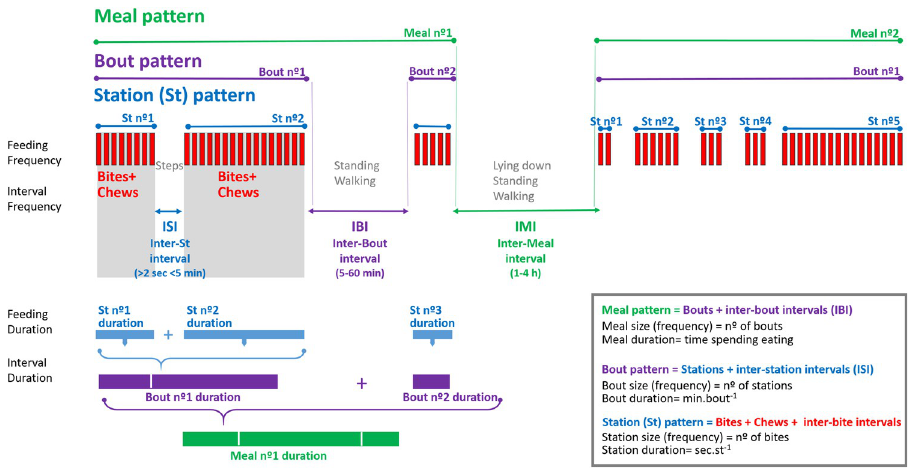
Fig 2. Components of a meal microstructure and definitions. (Adjusted for grazing ruminants, based on [28, 29]).